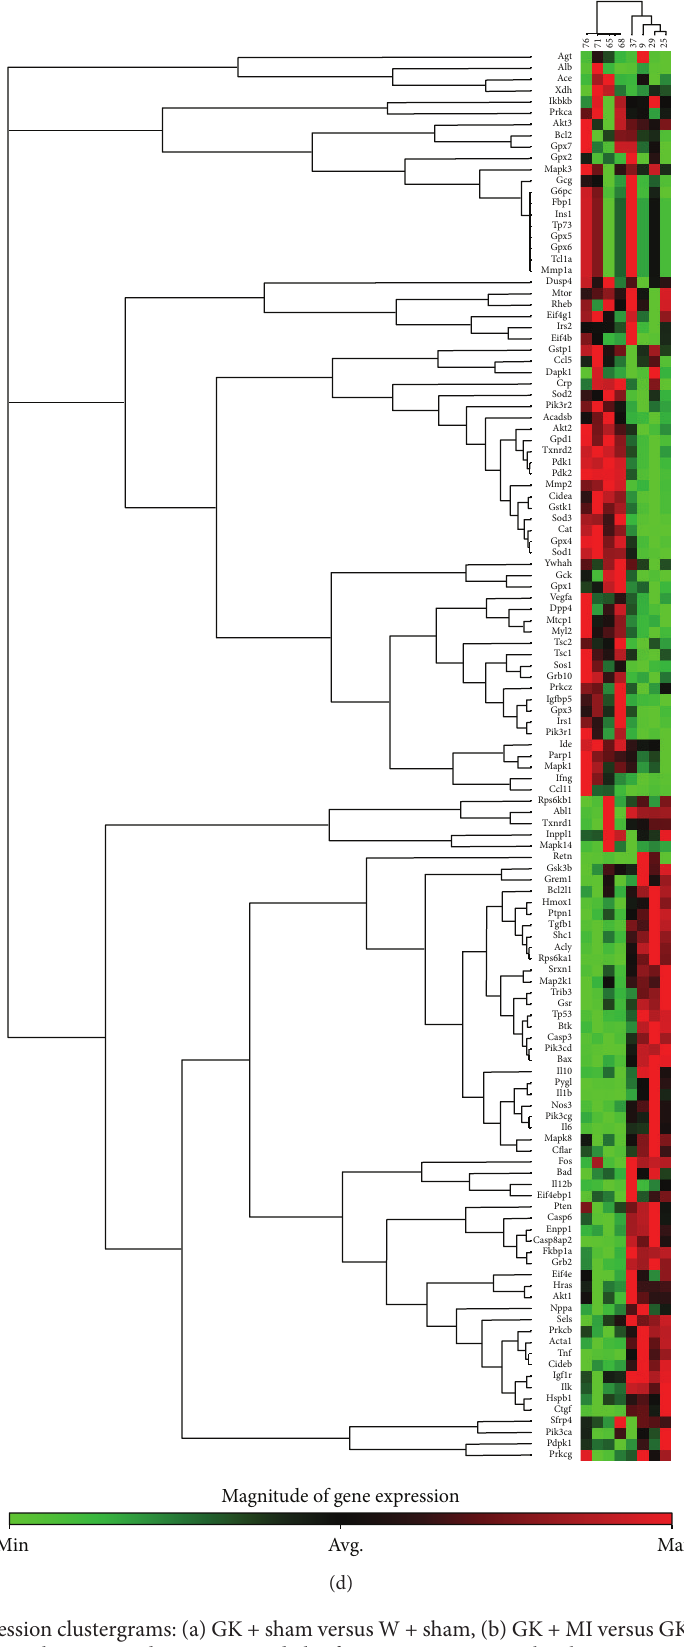
Figure 4: PCR array gene expression clustergrams: (a) GK + sham versus W + sham, (b) GK + MI versus GK + sham, (c) GK + MI versus W + MI, and (d) W + MI versus W + sham. MI indicates myocardial infarction; GK: Goto-Kakizaki; W: